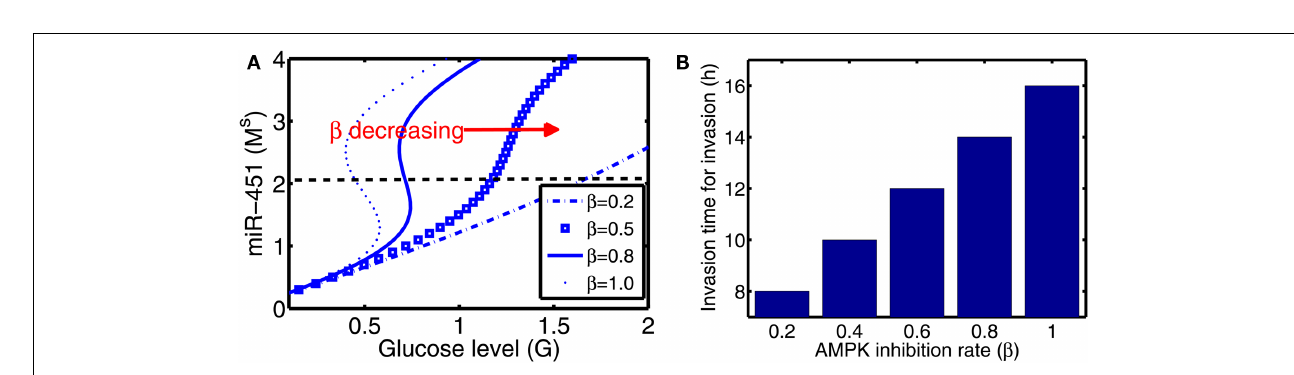
for glioma cell invasion in the hybrid model. As β is decreased, activation time for invasion is decreased. See Appendix A.2 for definition and role of β in the core